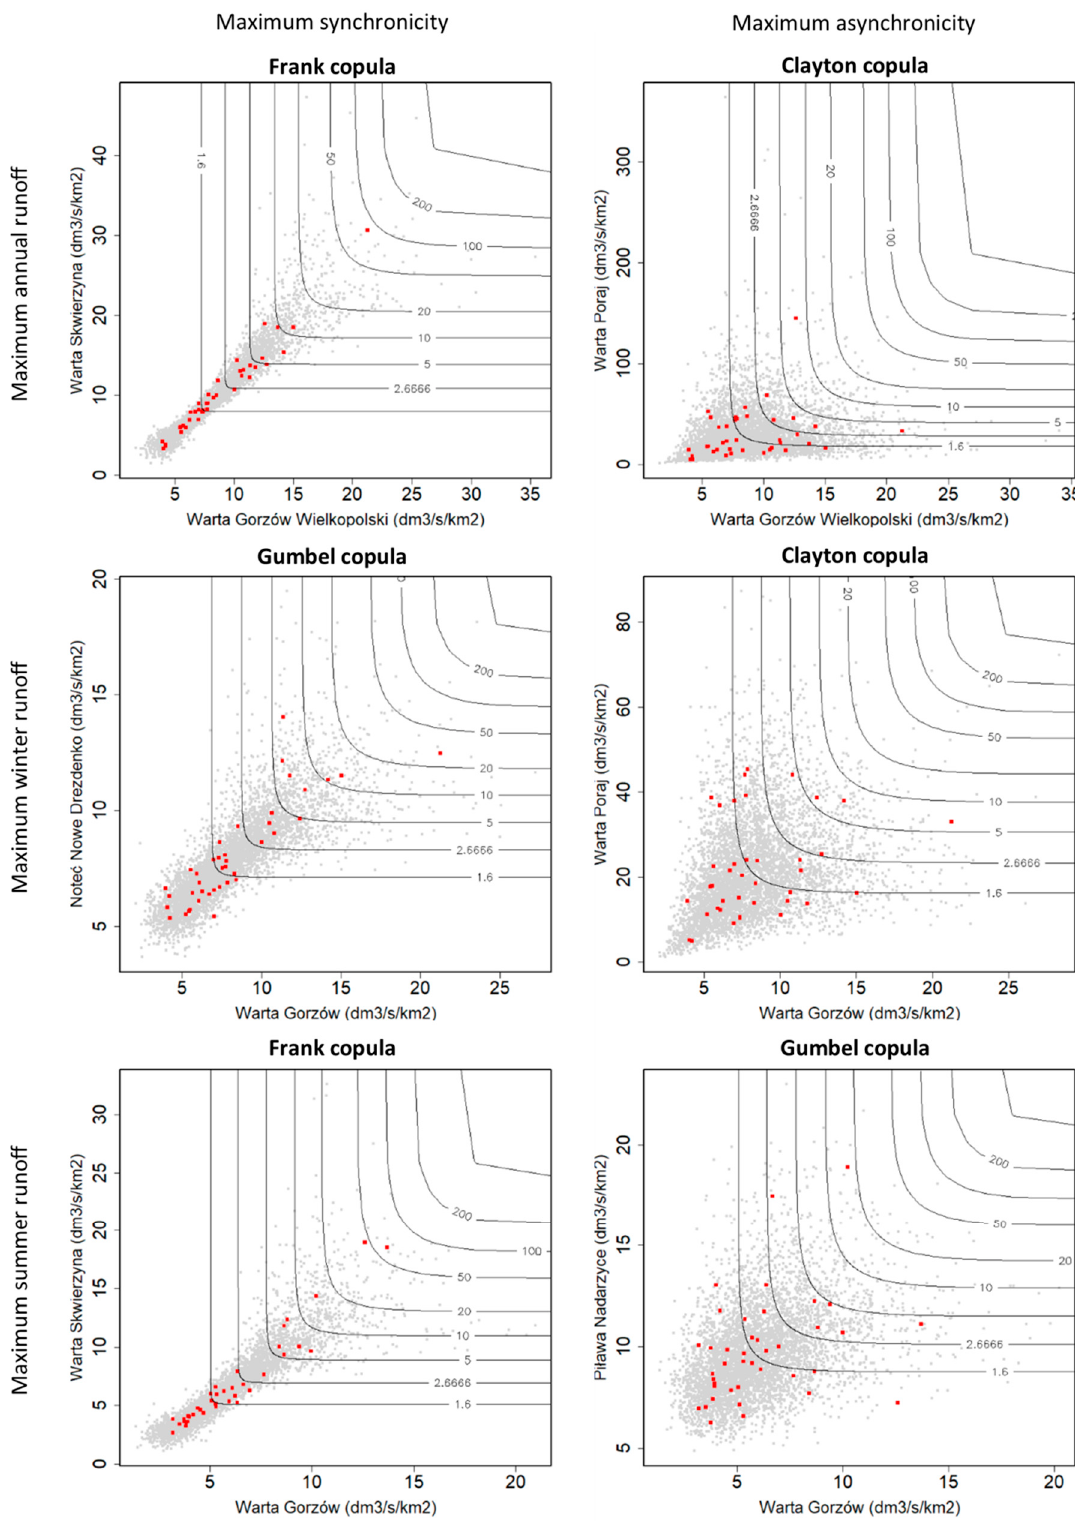
Figure 3. Copula plots of gauges with the maximum synchronicity and asynchronicity of the maximum runoffs in analyzed periods.